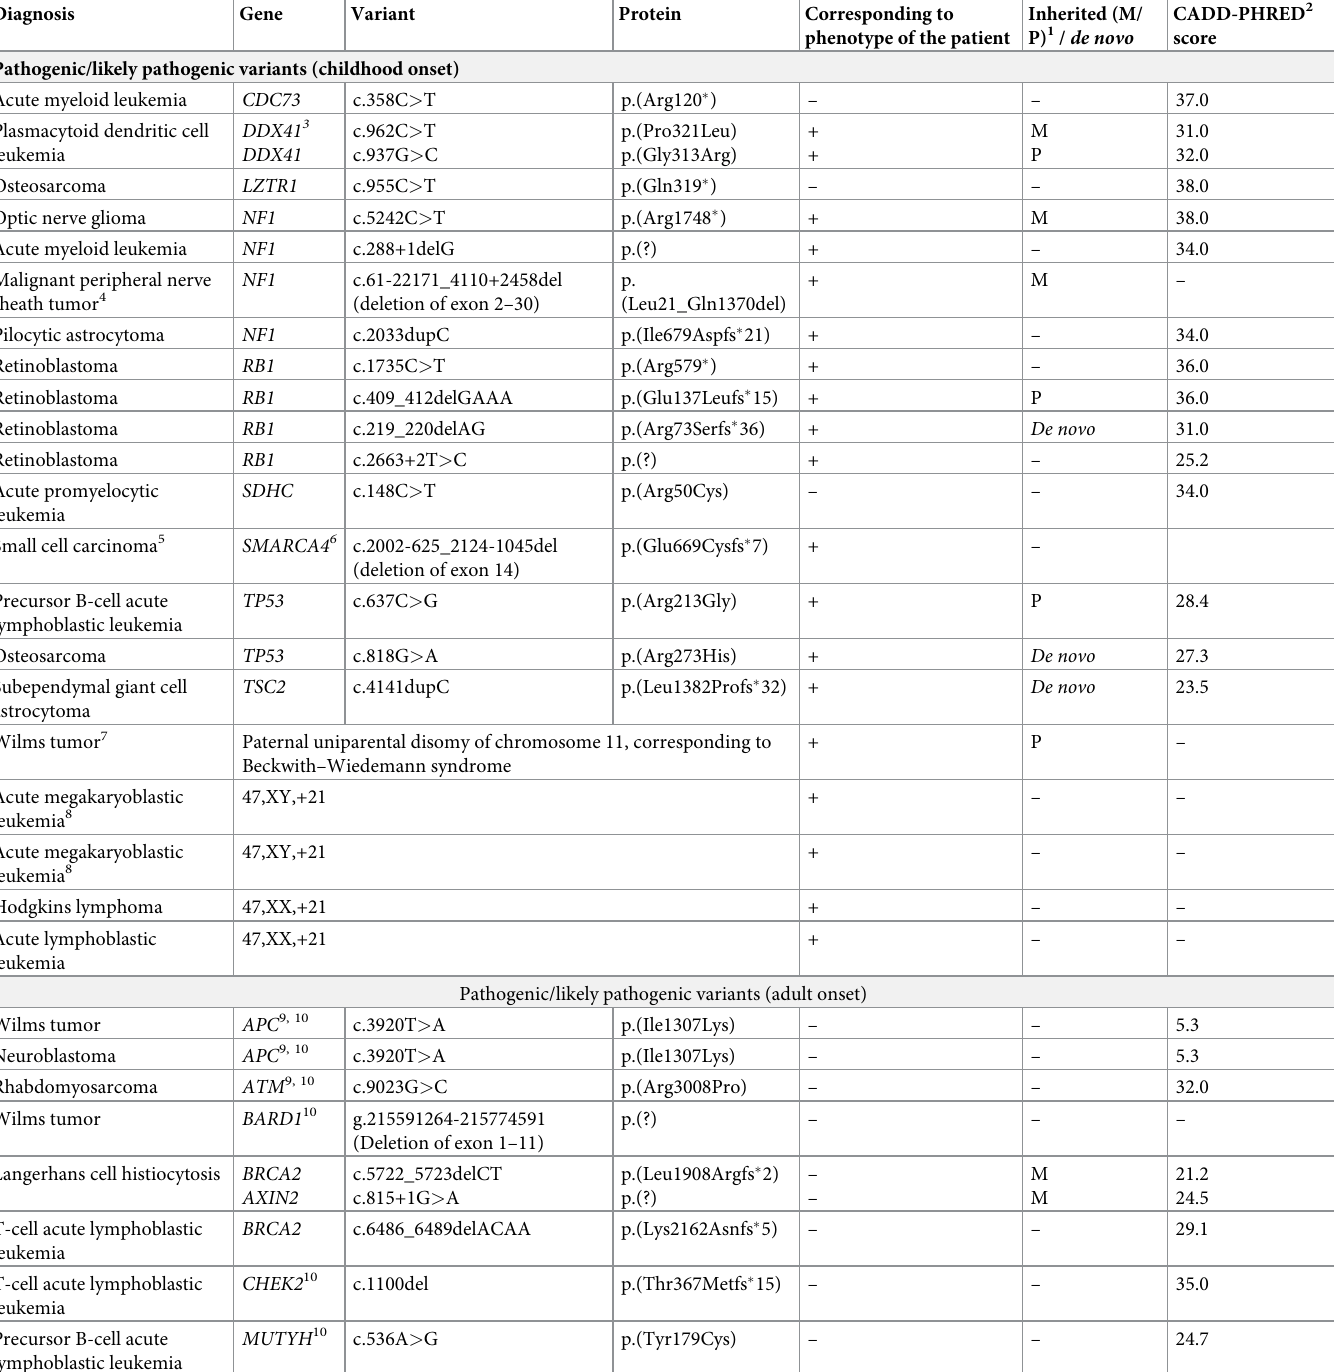
Table 4. Pathogenic and likely pathogenic variants in cancer predisposition